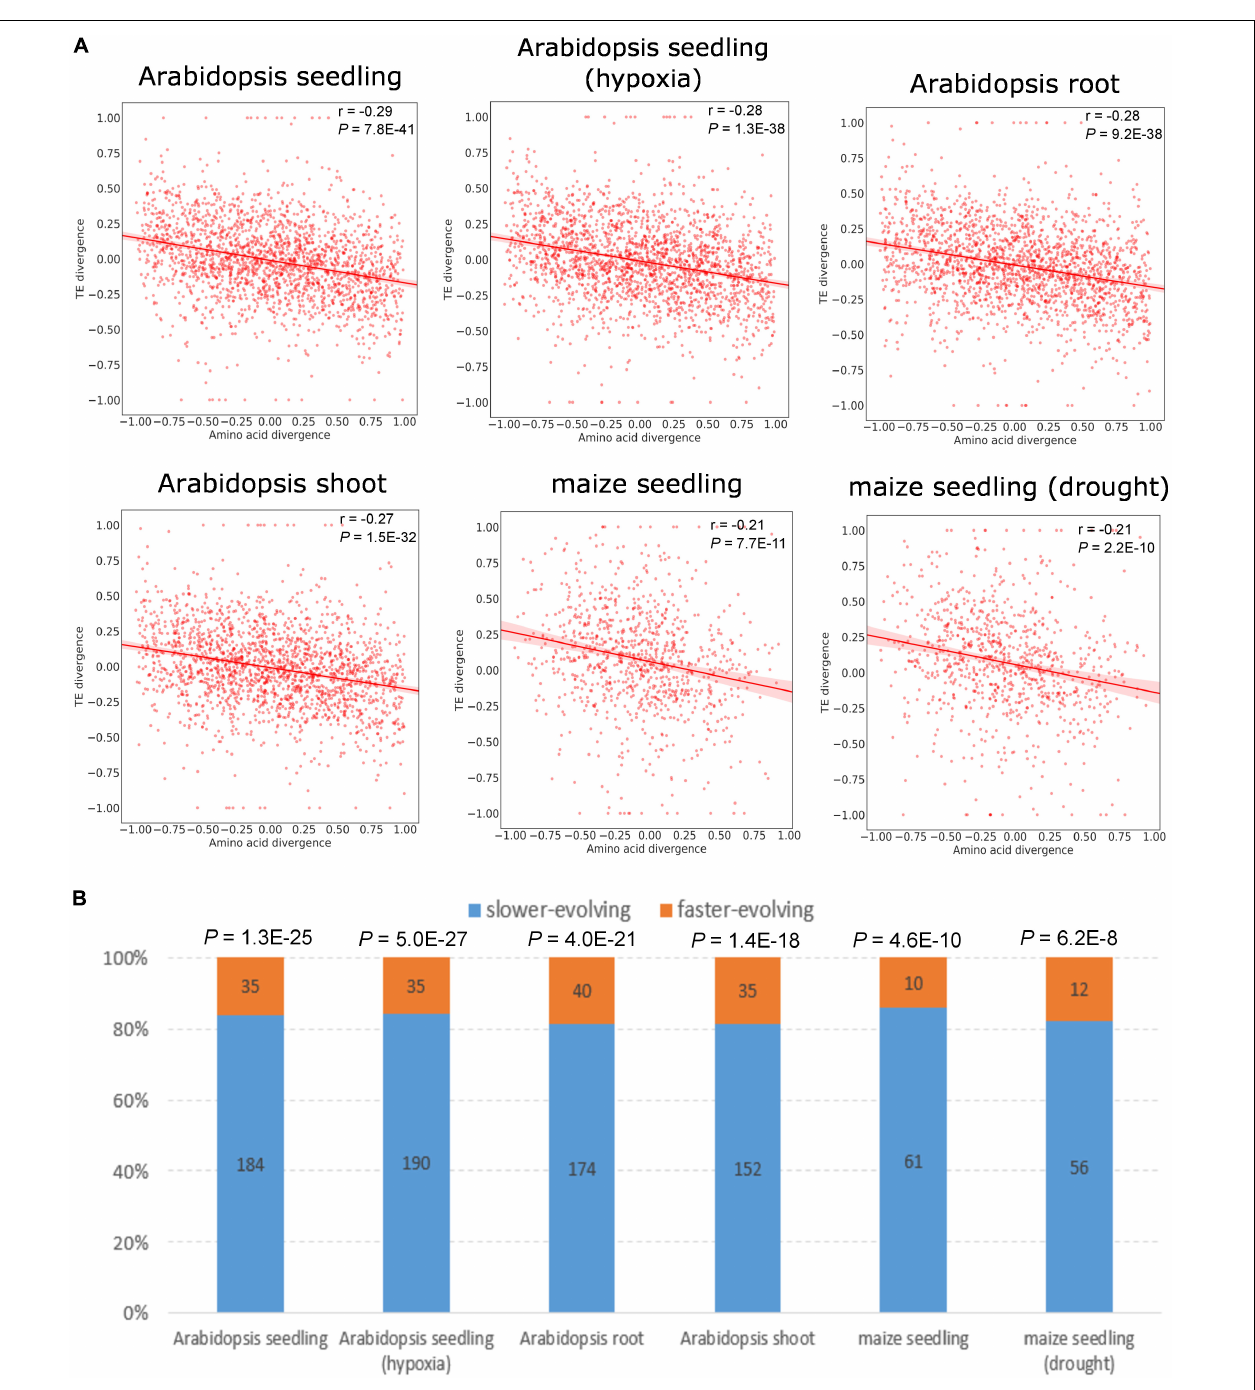
FIGURE 3 | Relationship between RF abundance divergence and amino acid divergence for WGD duplicates. Amino acid divergence is measured as non-synonymous substitution rate ( K a ), as widely used in prior studies (Li et al., 2005; Ganko et al., 2007; Hakes et al., 2007). (A) Correlation between the RF abundance divergence and amino acid sequence divergence. The Pearson’s correlation coefficient and P -value are indicated. The shaded areas represent 95% confidence interval in both plots. (B) Proportion of the paralog copy with the higher RF abundance between the slower- and faster-evolving copy in a duplicate pair. The y -axis represents the proportion of the paralog with the higher RF abundance. Bars in blue and yellow denote the slower-evolving and faster-evolving paralog copy, respectively. Numbers of duplicate pairs are given on the bar. P -values derived from a binomial test are shown above the bar.